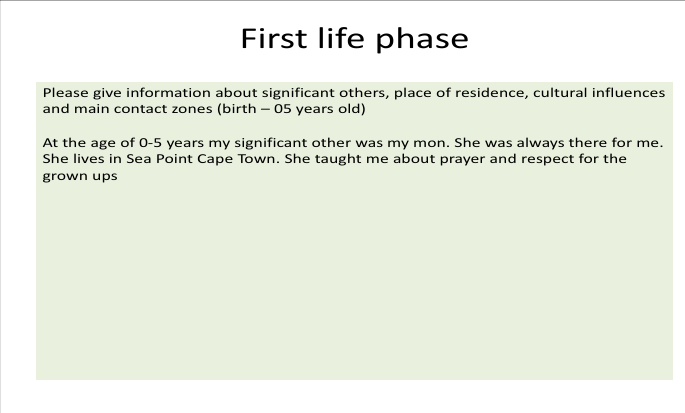
Figure 5. Tanaka’s timeline of her first life phase.